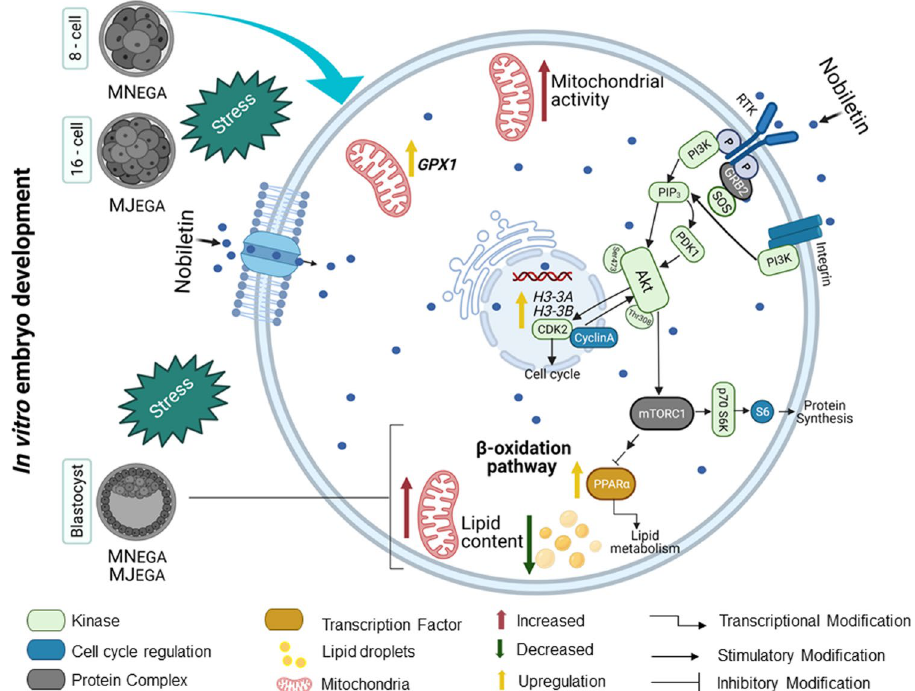
Figure 8. Schematic diagram illustrating the effect of nobiletin on bovine embryo development during the two EGA phases (MN EGA and MJ EGA ). Nobiletin a class of polymethoxylated flavone, is easily absorbed across the cytoplasmic membranes due to its structure and lipophilic nature 17 , but the specific mechanism of action is not clear yet. Nobiletin supplementation during EGA has a positive effect on preimplantation bovine embryonic development, also increase the abundance of CDK2 (cell cycle progression), H3‑3A , H3‑3B (development) and GPX1 (oxidative stress) transcripts in 8-cells and 16-cells embryos. In addition, the nobiletin effect in the produced blastocysts was reflected by stimulating mitochondrial activity, decreasing the cytoplasmatic accumulation of lipids and promoting the expression of genes that regulate lipid metabolism and protect against oxidative stress. Besides, these positive responses of nobiletin on embryonic development and quality of the produced blastocysts in vitro could be modulated by activation of the AKT signaling pathway. In our study increased AKT phosphorylation might be related to the increase in the production and the expression of genes that favor the progression of the cell cycle ( CDK2 ) and reducing lipid content ( PPARα ). However, further studies are needed to fully elucidate its mechanism of action in early embryos. Figure created with